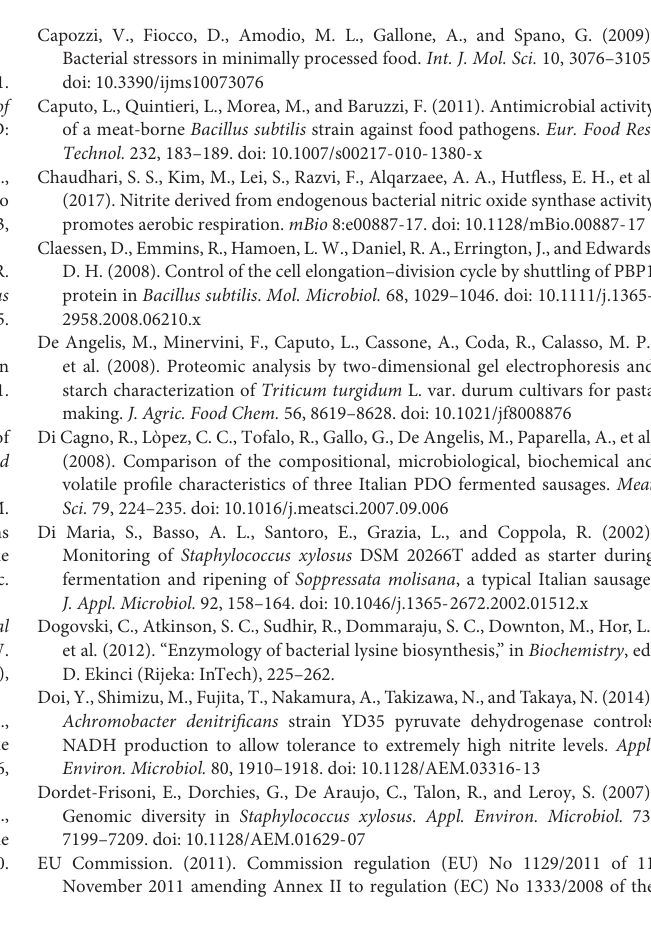
FIGURE S1 | Score plot obtained from principal component analysis (PCA) of two-dimensional electrophoresis (2DE) spot match dataset. Plot displays grouping of S. xylosus DSM 20226T cultures with respect of aerobiosis and anaerobiosis (open circle and square, respectively) along component 1 (PC1) and in relation to presence and absence of nitrite (filled circle and square, respectively) along components 2 and 3 (PC2 and PC3). TABLE S1 | Additional information for the differentially expressed proteins ( P < 0.05; Fold > 2) listed in Table 2